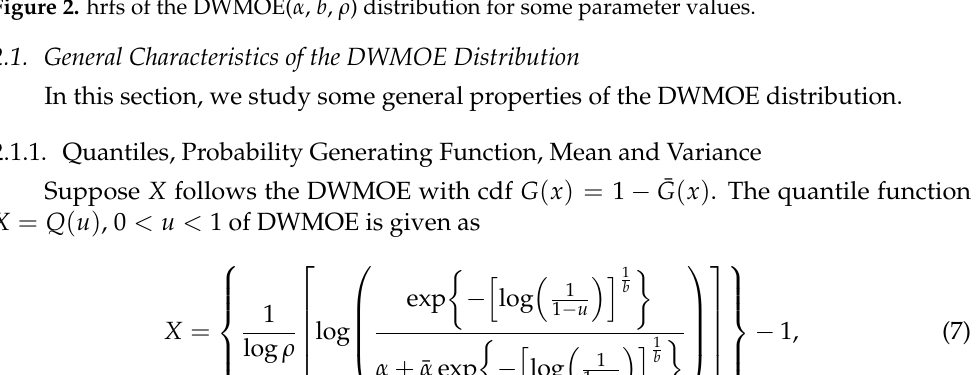
Figure 2. hrfs of the DWMOE( α , b , ρ ) distribution for some parameter